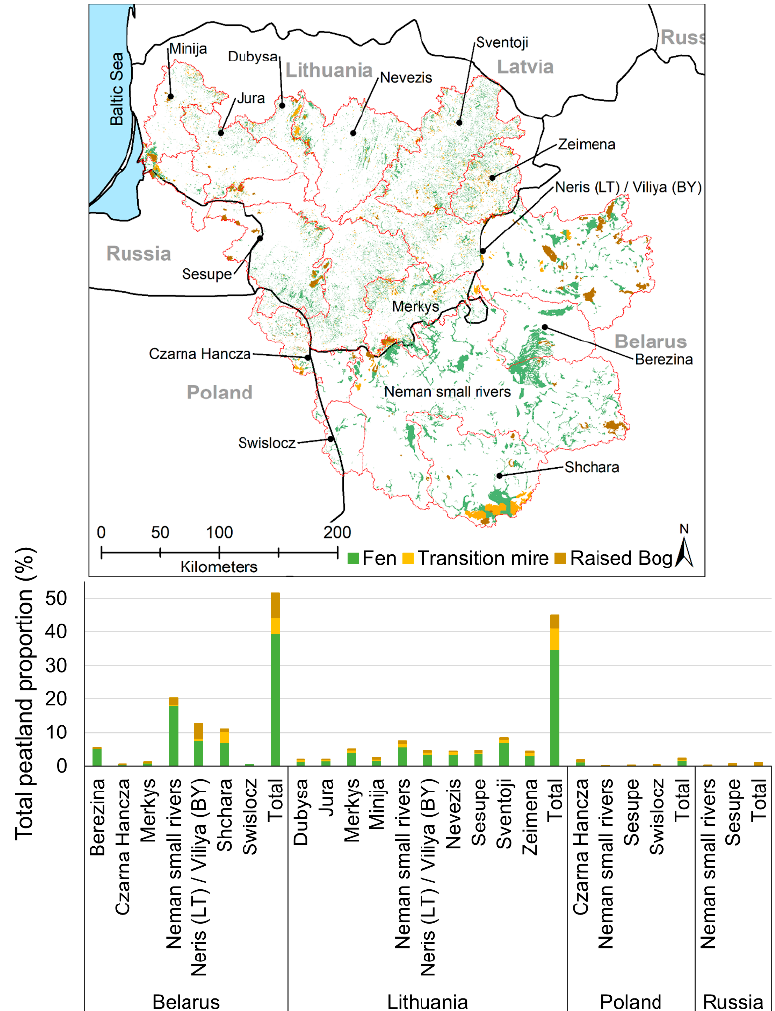
Figure 3. Map of peatlands and their area proportions within the entire Neman River basin by country, sub-basin, and peatland type (fen, transitional mire, and raised bog). Spatial analyses of the Neman River basin showed the mean peatland patch size distribution varied by country and peatland type, with Belarus having the largest mean patches size for both fens (62 ha) and transitional mires (153 ha), and Russia for raised bogs (657 ha). The smallest peatland patch size for fens and transitional mires was recorded by Lithuania with 5 and 7 ha, respectively. Poland recorded the smallest mean raised bog patch size with 9 ha (Table 2, Figure